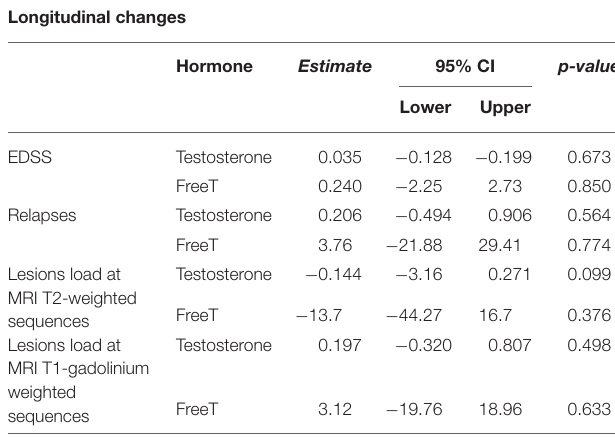
Table 4 | Hormonal assessment and spermatic parameters in RRMS patients at enrolment and after 12 months. Variables* AT Enrolment